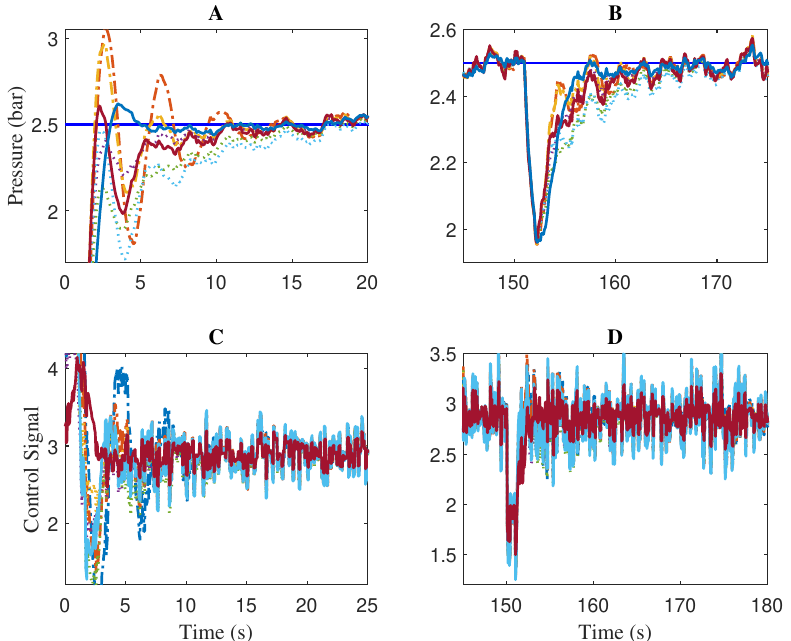
Figure 9. Zoomed regions of Figure 8 showing the process output ( A , B ) and control action ( C , D